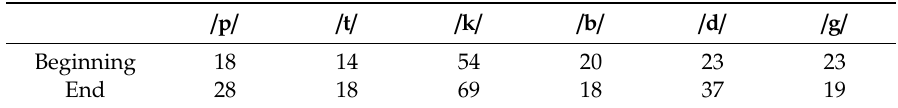
Table A13. Token counts for consonant measurements used to assess changes in production of voiceless and voiced consonants by Informant E in Sections 4.1.1 and